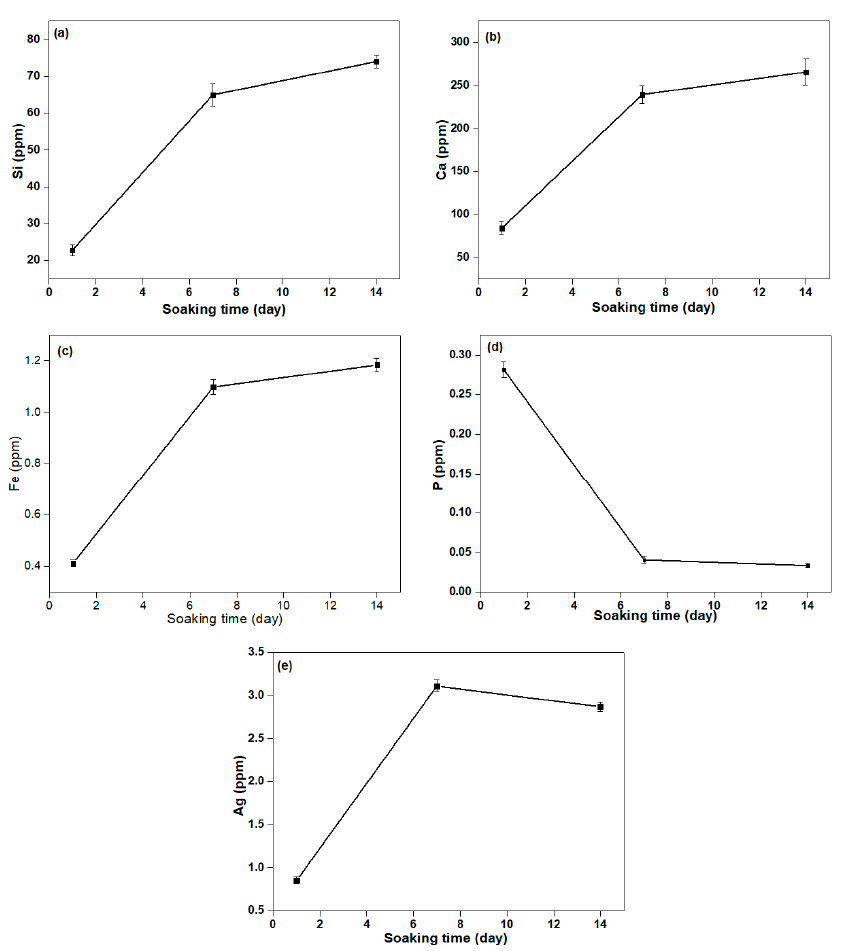
Figure 8. The concentration of ( a ) Si, ( b ) Ca, ( c ) Fe, ( d ) P, and ( e ) Ag ion release from β WMAF samples in the SBF solution for 1, 7, and 14 days.